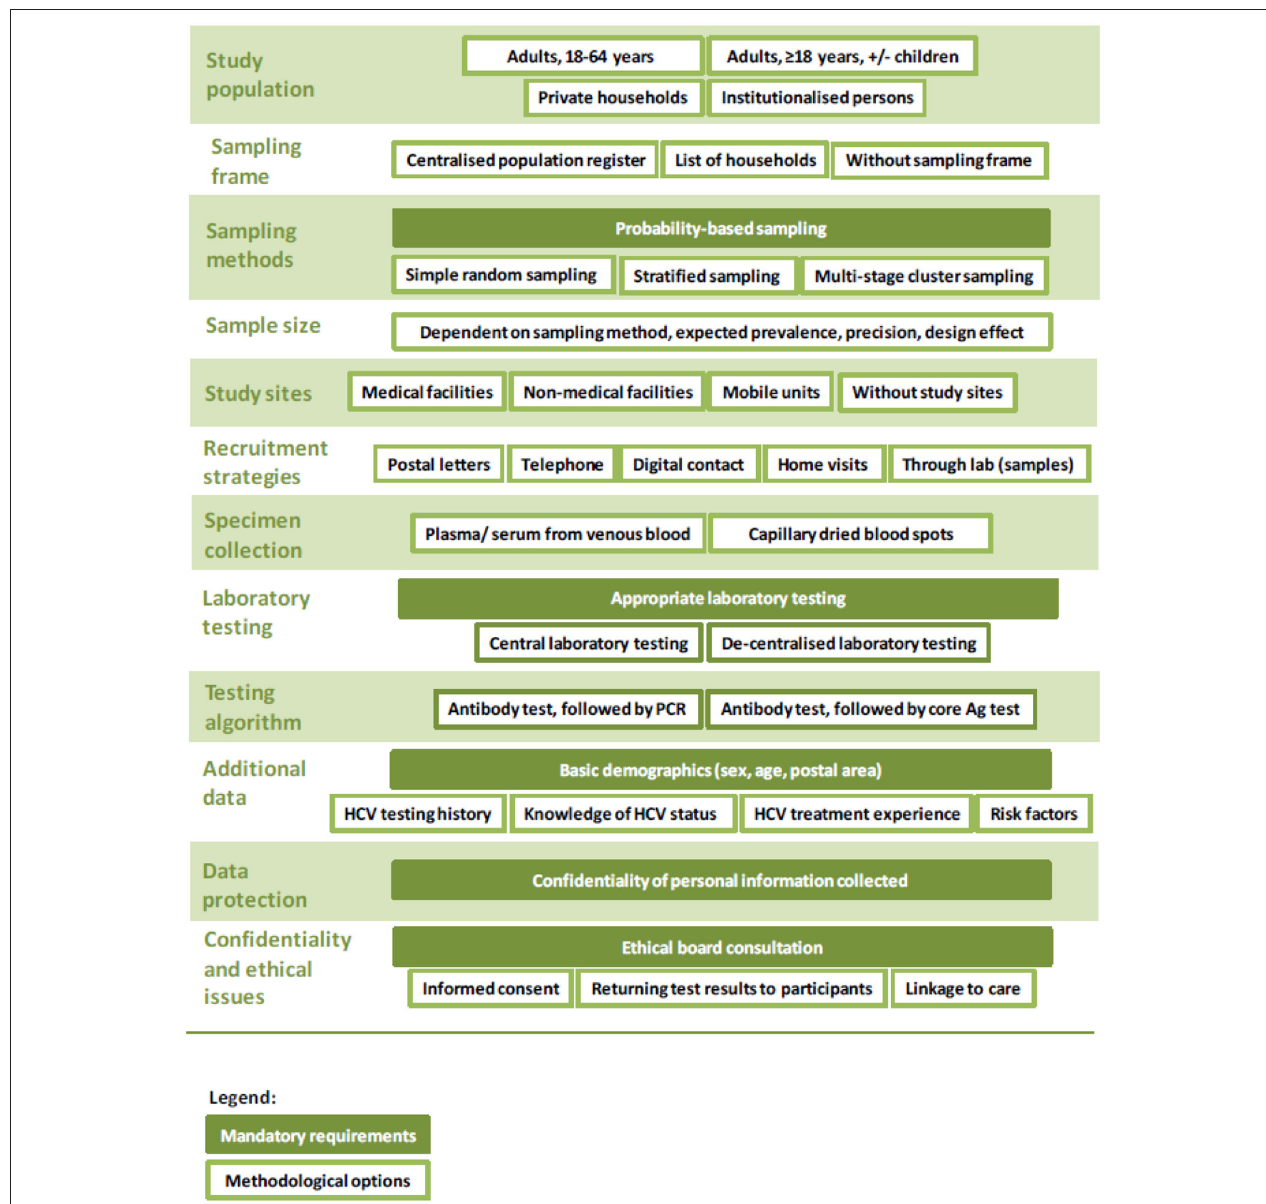
FIGURE 1 | Overview of mandatory requirements and methodological options for an HCV prevalence